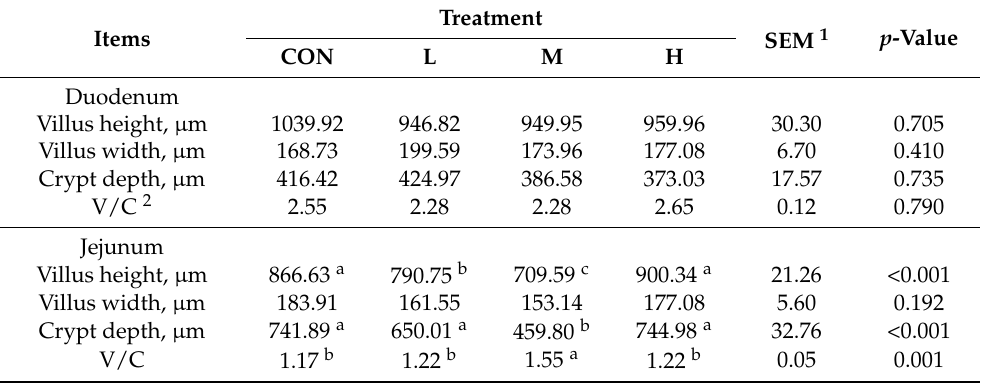
Table 5. Effects of replacing 0 (CON group), 20 (L group), 40 (M group) and 60% (H group) of maize silage with mulberry silage on lambs’ gastrointestinal tissue morphology. Items Table 5. Cont.